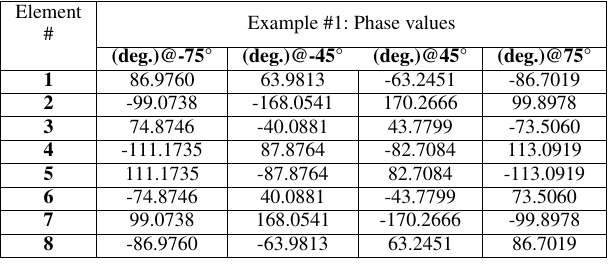
TABLE 3. Optimum Phase values found by Taguchi-RBF Neural Networks Element #